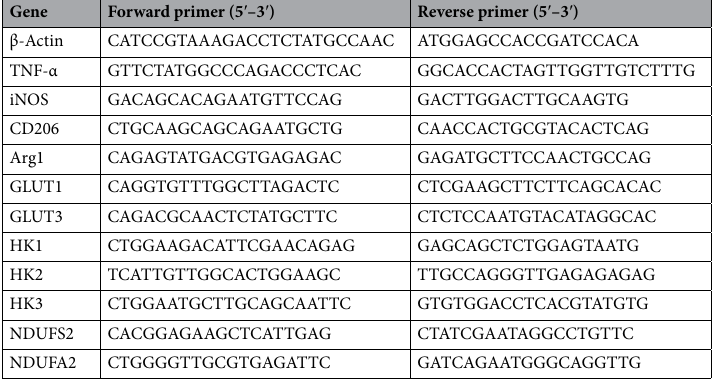
Table 1. Sequences of primers used for